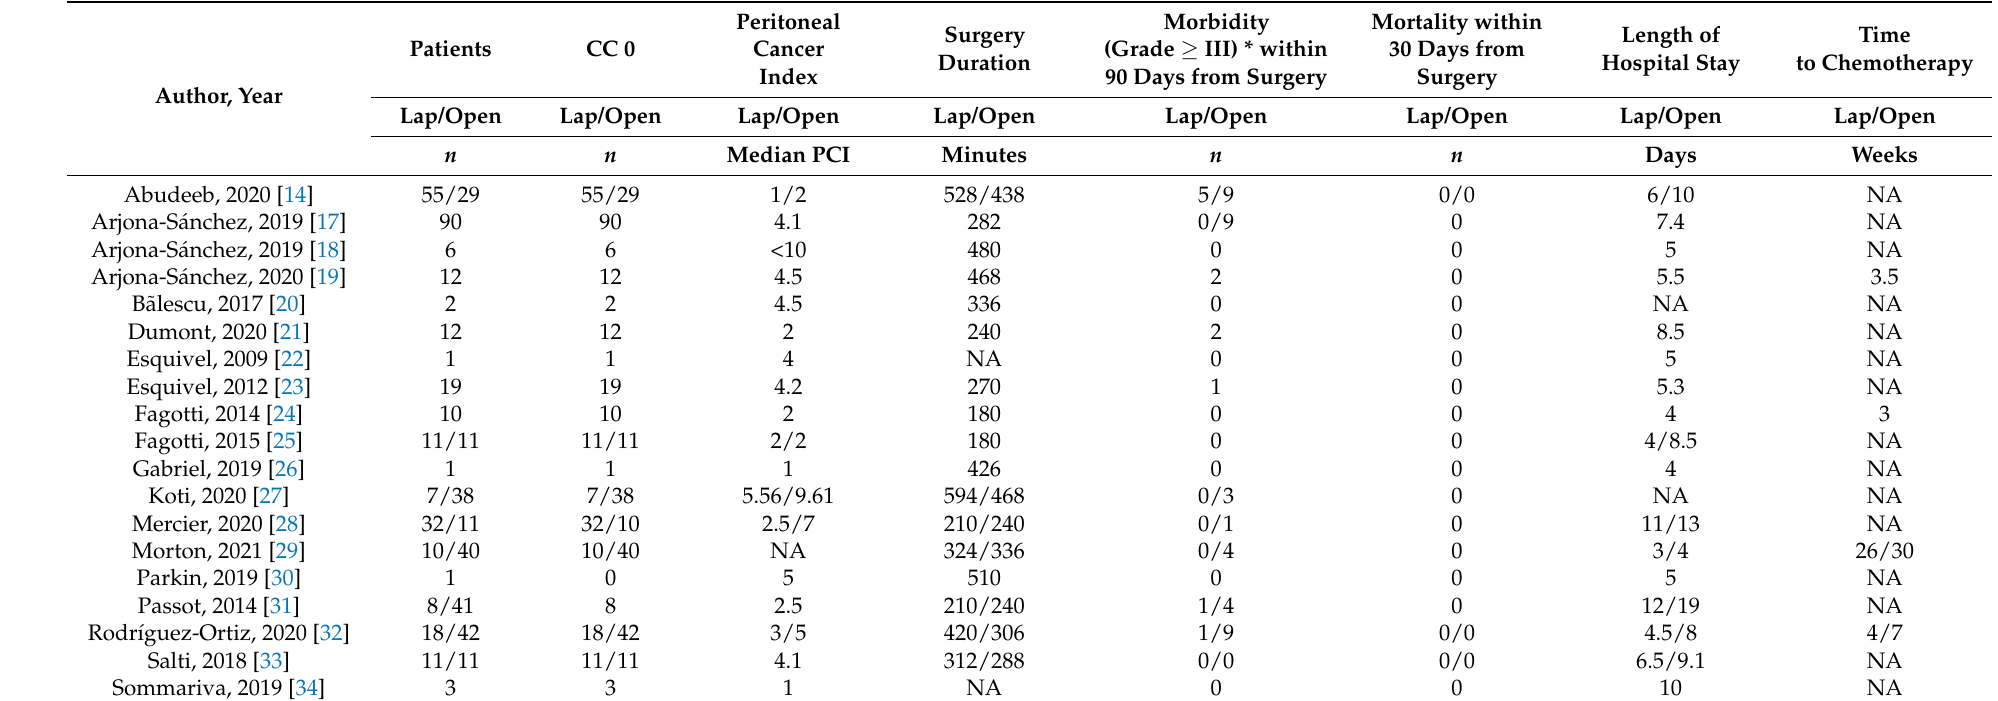
Table 3. Intraoperative and postoperative